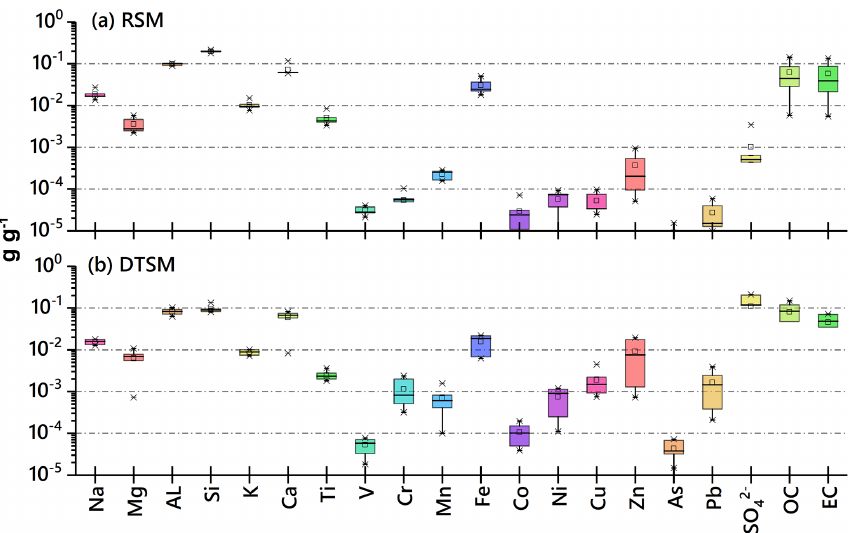
Figure 4. Characteristics of chemical profiles for PM 10 emitted from a coal-fired power plant obtained using different sampling methods in Wuxi city. RSM and the DTSM denote the resuspension sampling method and the dilution tunnel sampling method, respectively. Data were acquired from the Nankai University source